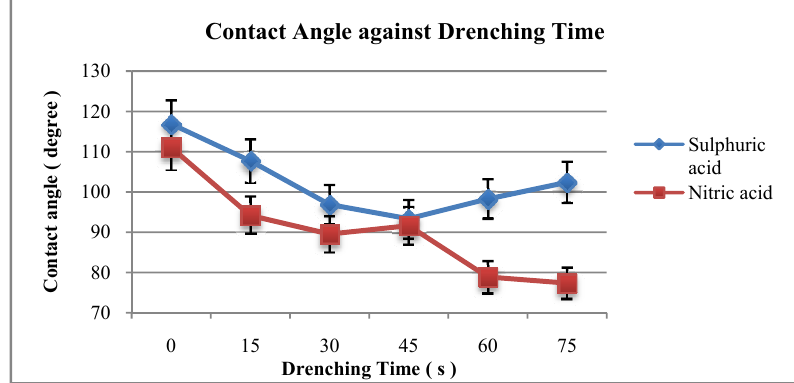
Figure 8. Average contact angle of distilled water droplets on a PDMS surface treated with Piranha